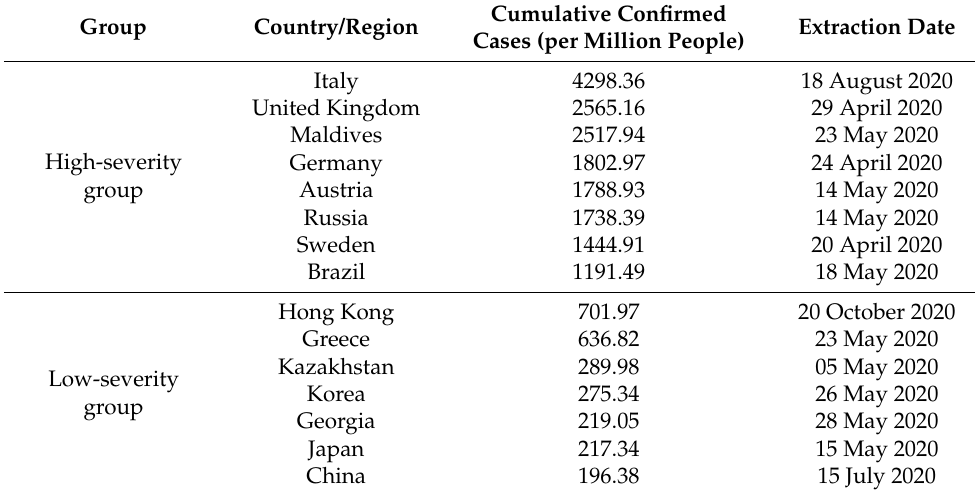
Table A2. Country/region-level severity. Group